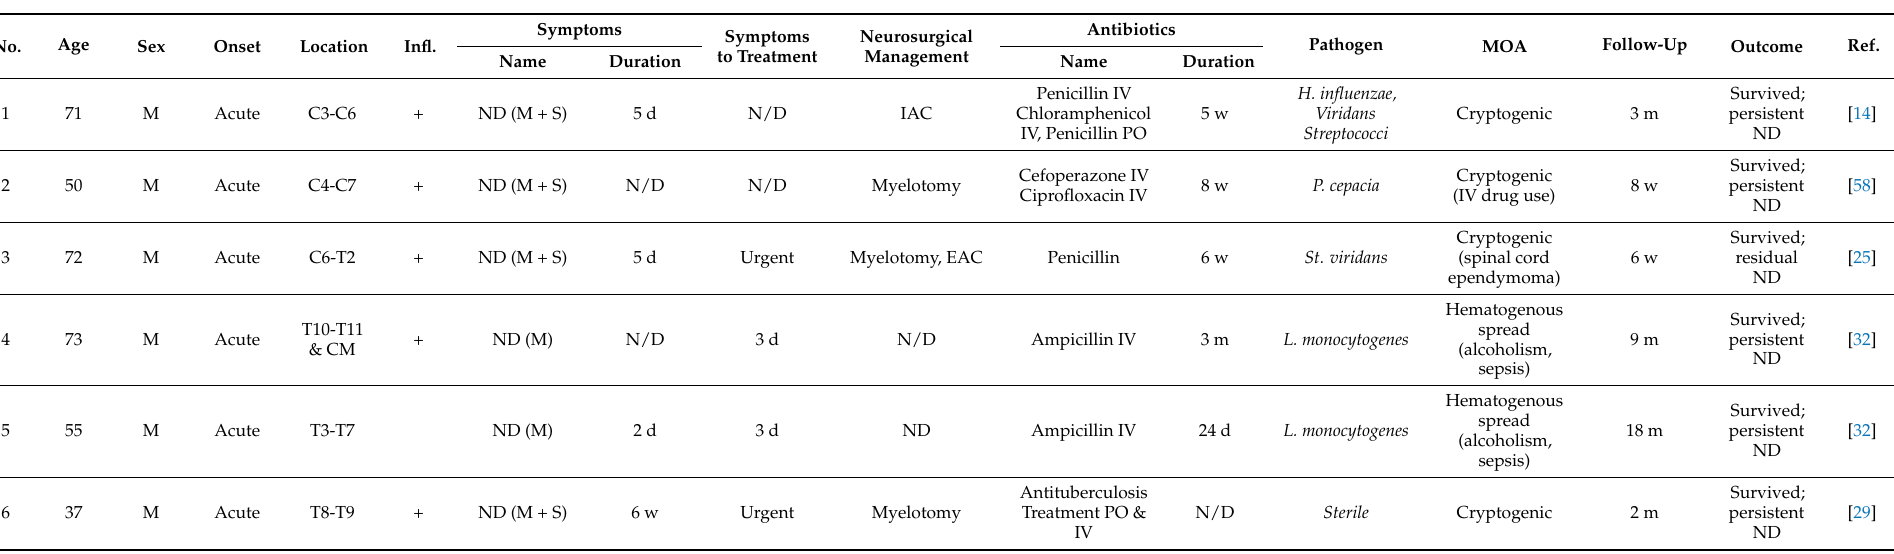
Table 4. Persistent group—summary of the clinical data, patient demographics, clinical manifestations, duration, microbiology, interventions and therapies,